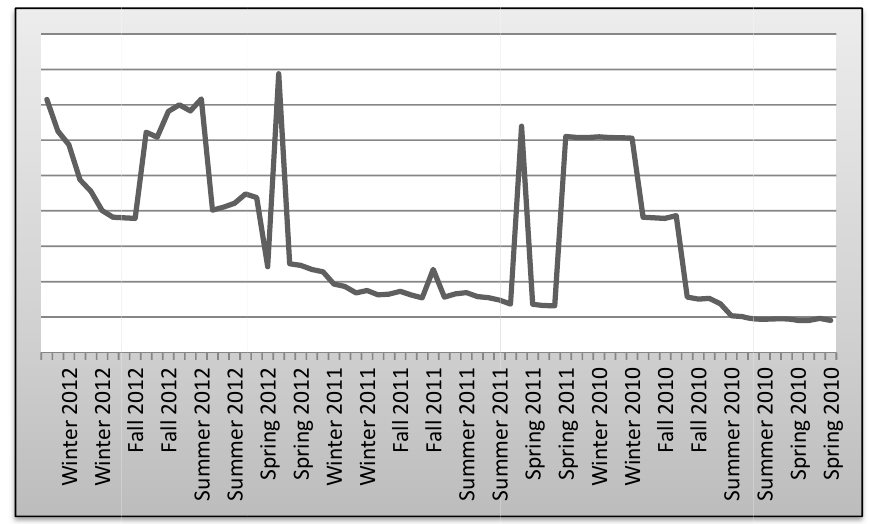
Fig. 3. Tren sing interes